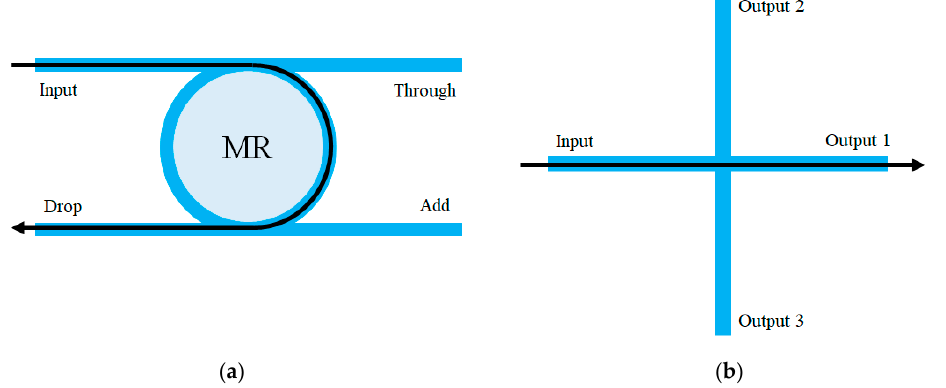
Figure 1. Two major insertion losses in optical network-on-chip (ONoC): ( a ) Microring (MR) drop loss; and ( b ) waveguide crossing loss.